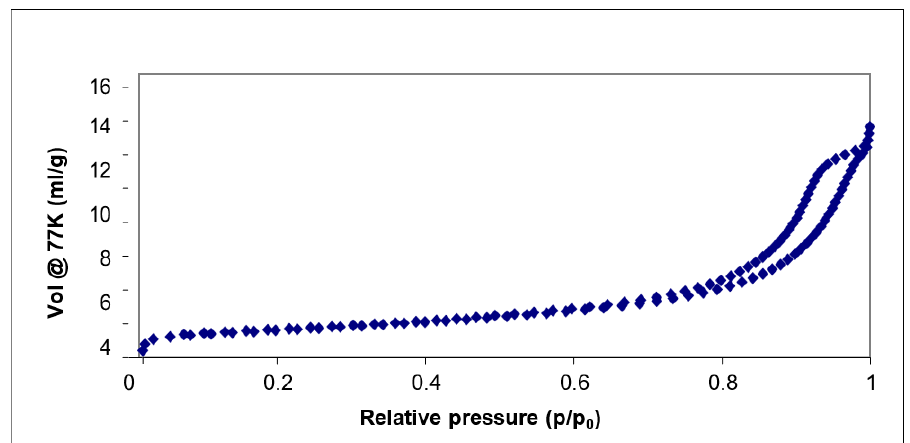
Figure 6. Analysis of the specific surface area of Skye sand.